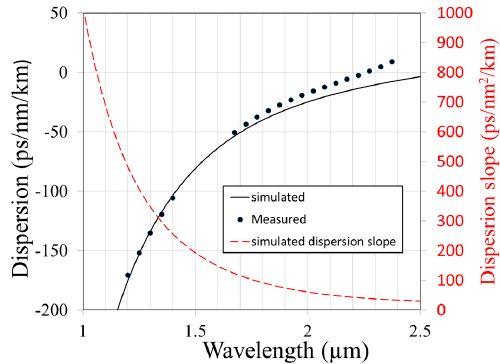
Figure 7. Fiber dispersion measured by low-coherence interferometry (dots) and simulated fiber dispersion (line).